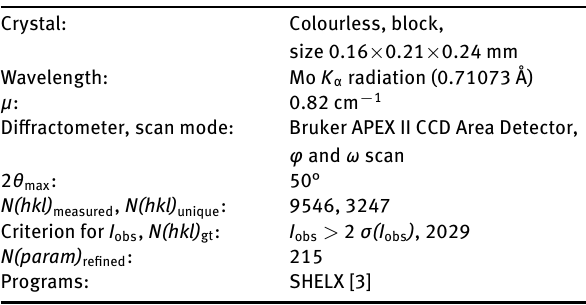
Table 1: Data collection and handling.